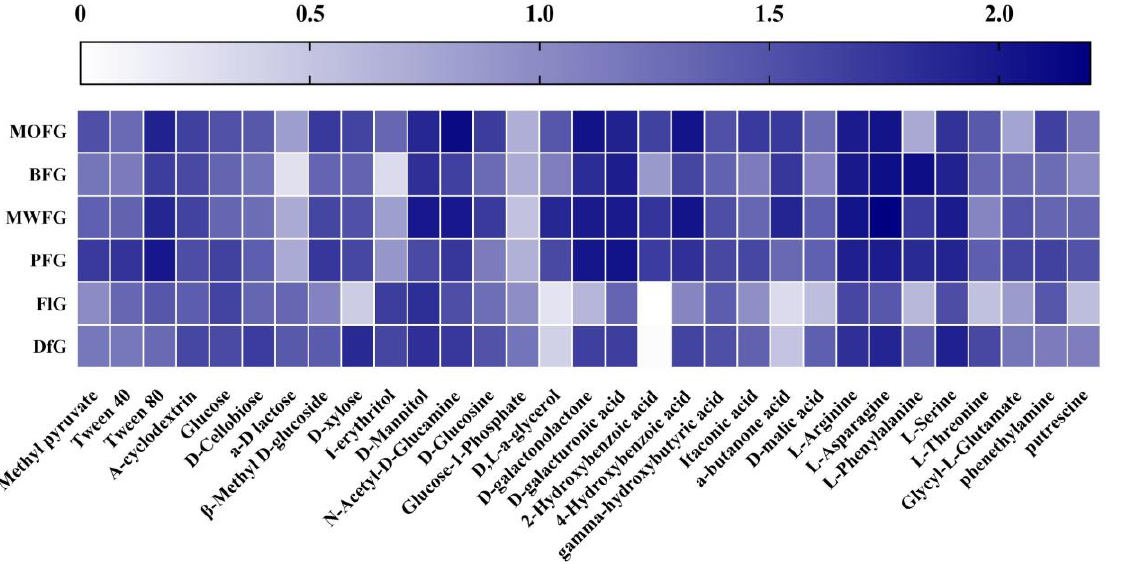
Figure 2. Use degree of a single carbon source by a soil microorganism. MOFG, Mongolian oak forest ginseng; BFG, birch forest ginseng; MWFG, miscellaneous wood forest ginseng; PFG, poplar forest ginseng; FlG, farmland ginseng; DfG, deforestation ginseng. The depth of color represents the use degree of soil microorganisms to the corresponding carbon source. The darker the color is, the stronger the use degree is, and vice